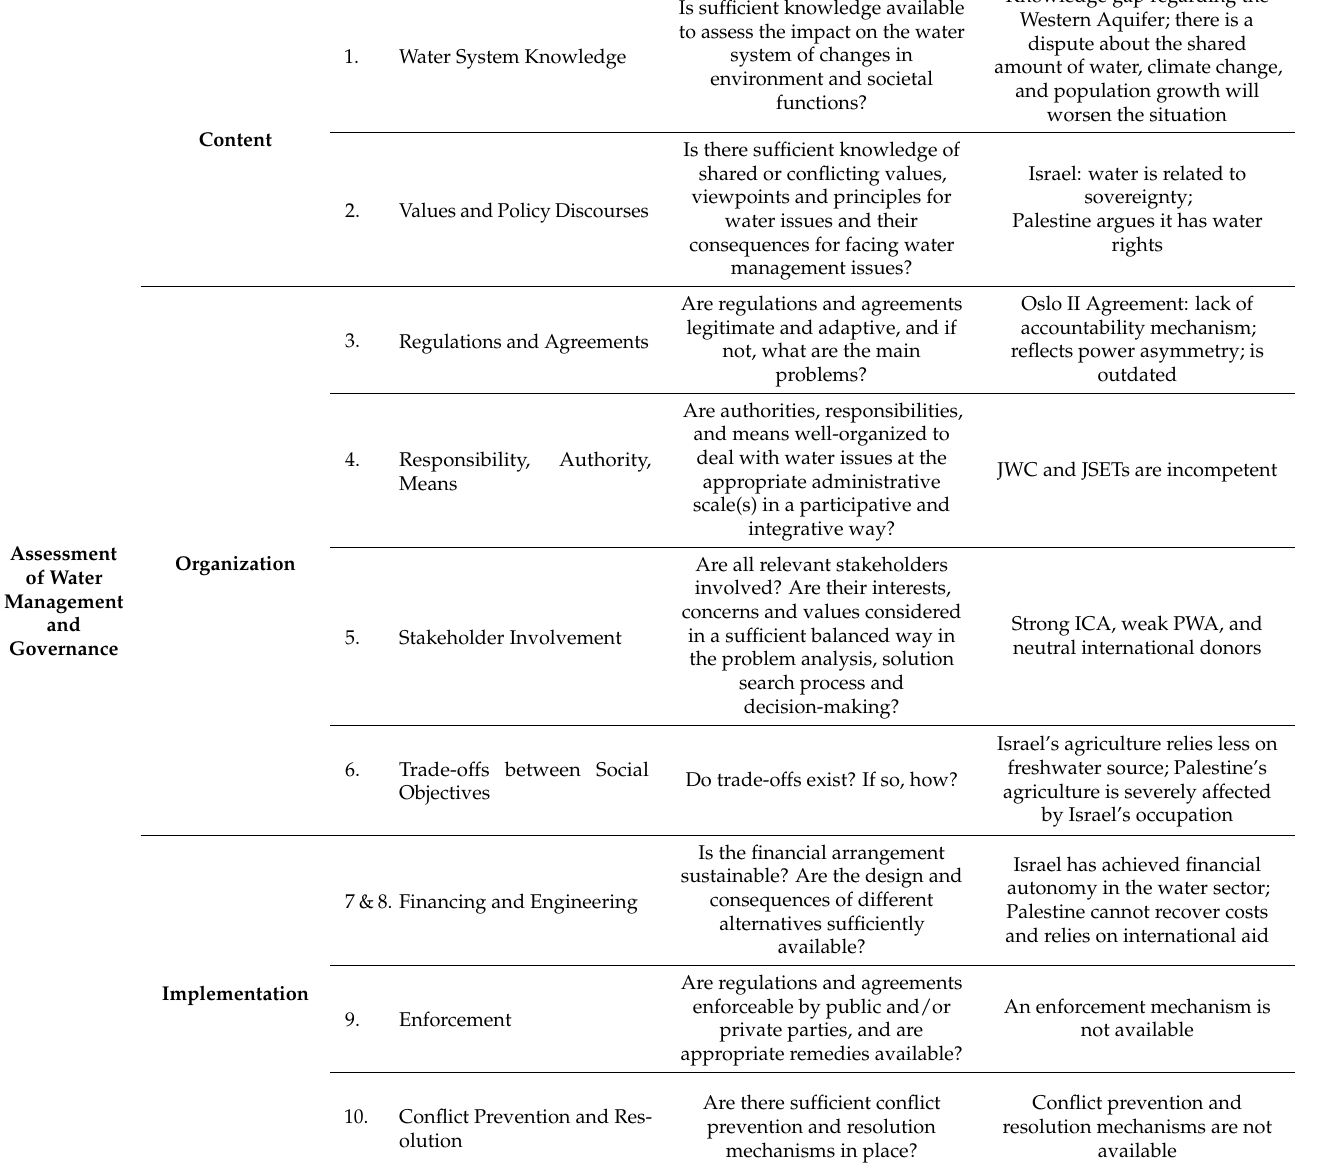
Table 2. An Overview of the Assessment of Constraints to Israel–Palestine Water Cooperation on the Mountain Aquifer.